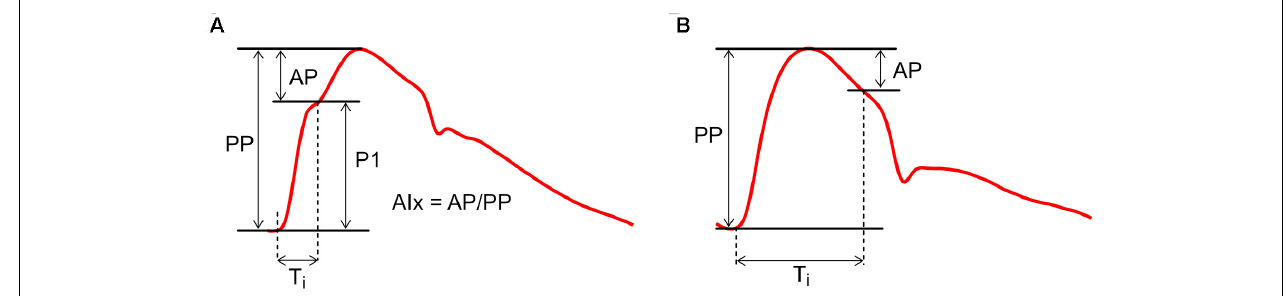
FIGURE 3 | Calculation of Augmentation Index (AIx) with examples of (A) positive augmentation and (B) negative augmentation. AP, augmentation pressure; P1, initial pressure rise; PP, pulse pressure; T i , inflection